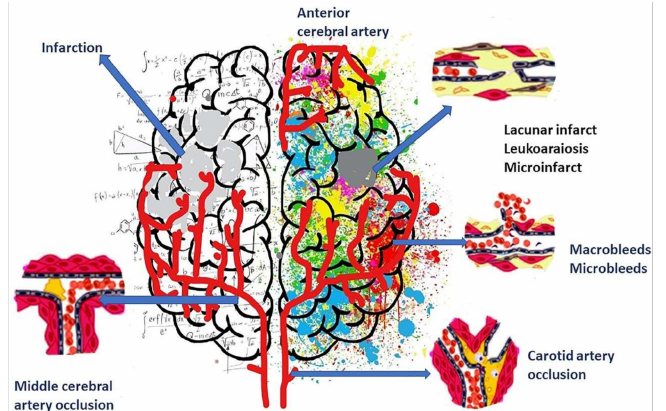
Figure 1. Microinfarct, Lacunar infarct, macro infarct, micro-bleed, hemorrhage, and white matter changes were observed in vascular